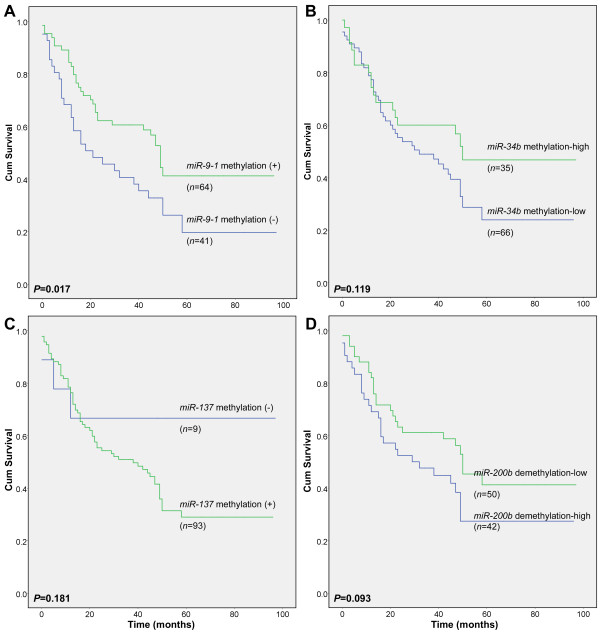
Overall survival curves of GC patients with different methylation status of 4 miR CpG islands in Kaplan-Meier analysis. (A) miR-9-1 methylation used as the classifier; (B) miR-34b methylation used as the classifier; (C) miR-137 methylation used as the classifier; (D) miR-200b demethylation used as the classifier.